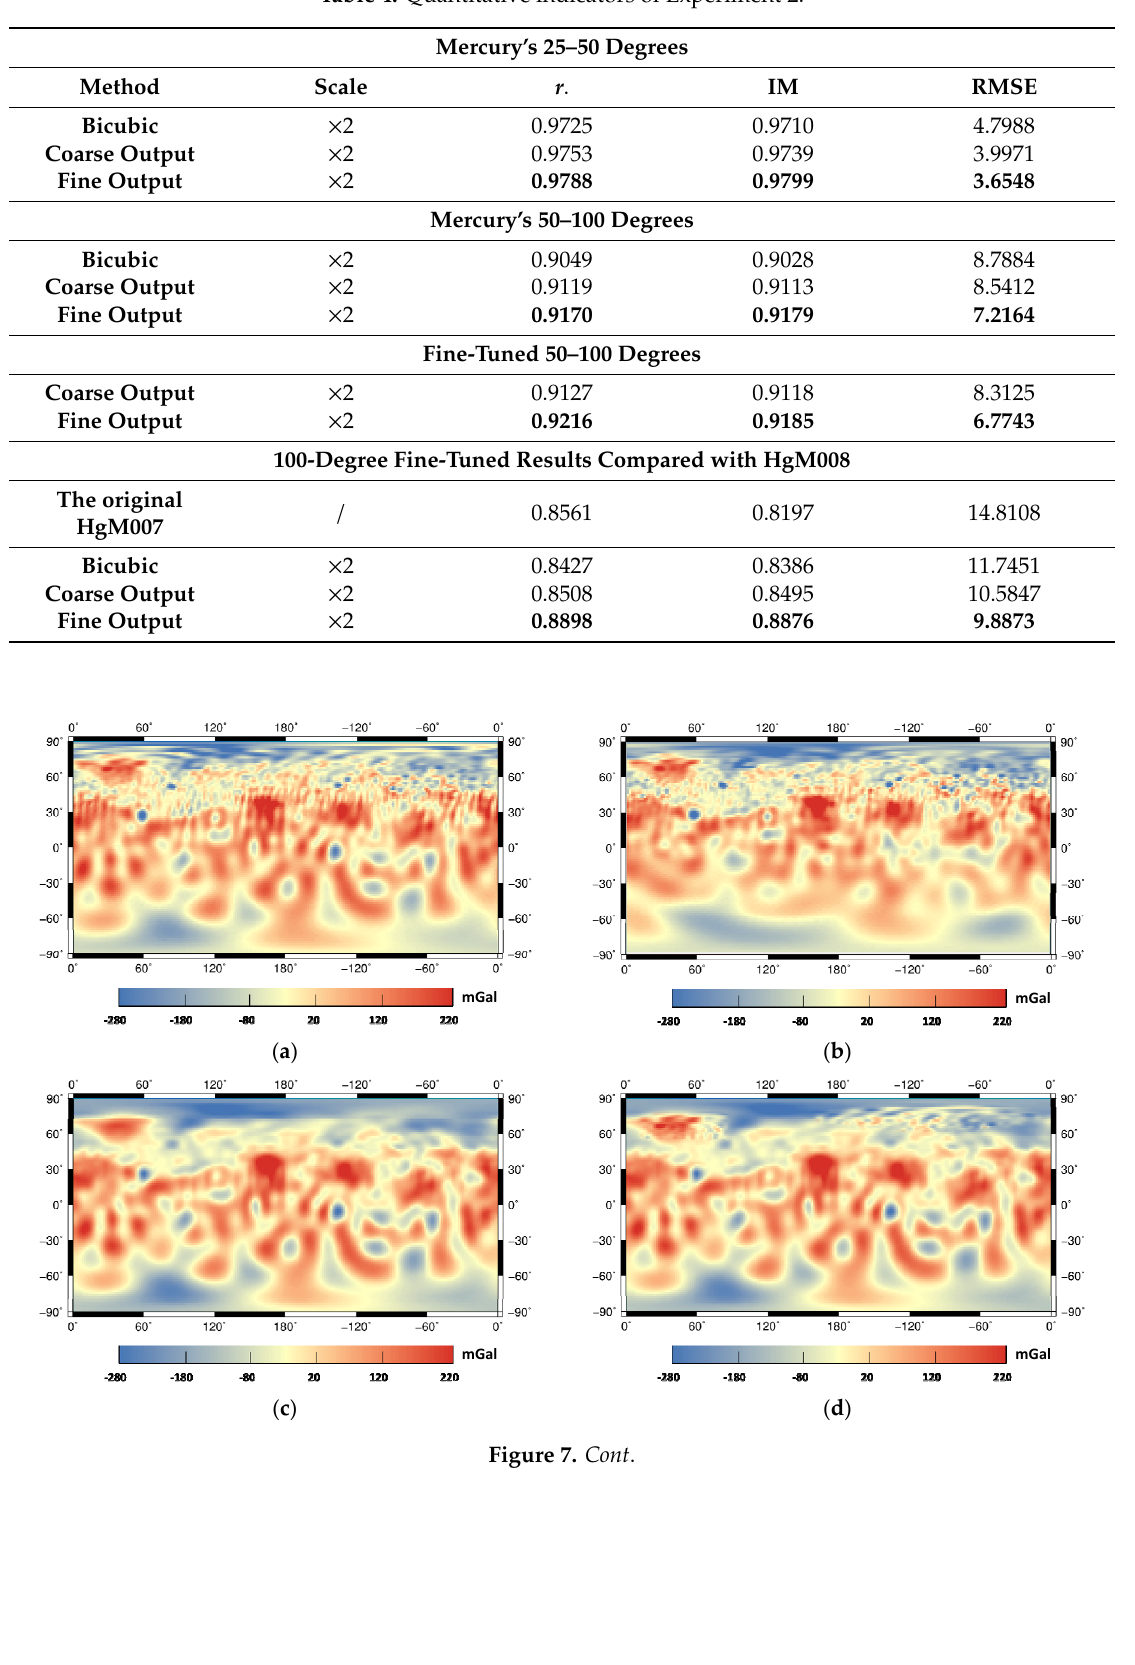
Table 4. Quantitative indicators of Experiment 2.